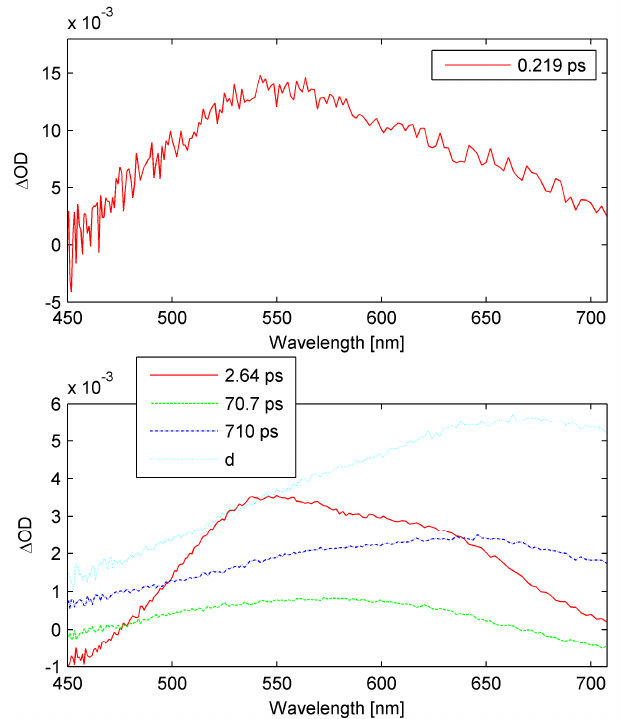
Figure 8. Spectral basis vectors for molecule “C”. See Equation (1) for explanation. While the optimizer converged for the 0.22 ps decay, too few data points were available to give a trustworthy fit.